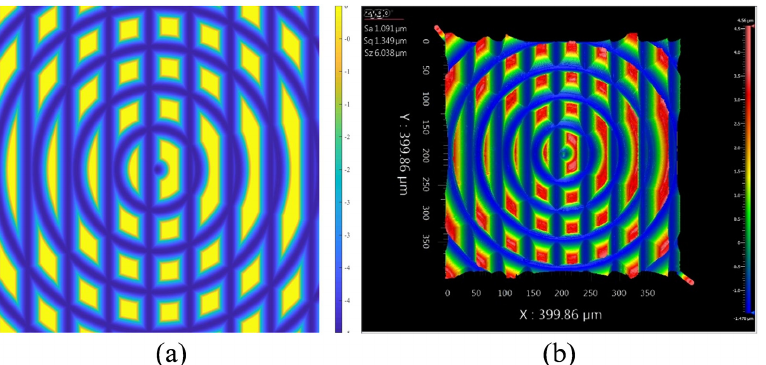
Figure 9. Comparison between modeling and experimental results: ( a ) Simulated surface texture, ( b ) measured surface texture. Machining conditions: Material: Nickel-Copper; Tool radius: 43 μ m; Groove spacing: 50 μ m; Depth of cut: 5 μ m.